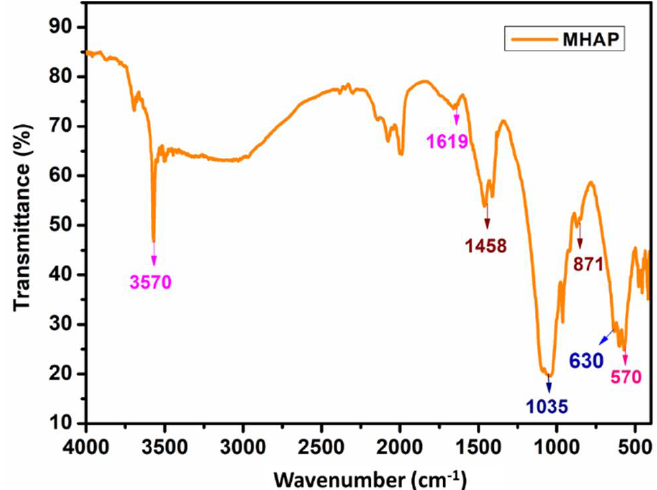
Figure 4. FT-IR spectrum of magnetic hydroxyapatite nanoparticles.